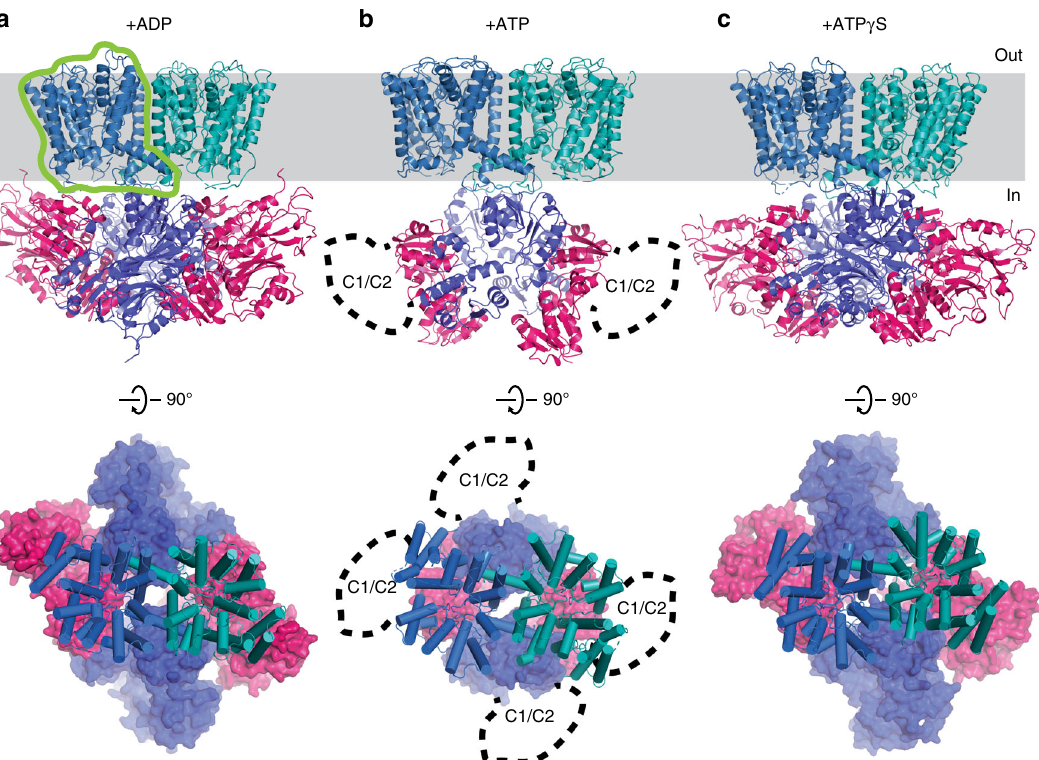
Fig. 1 Structure of TrkHA in the presence of ADP, ATP, or ATP γ S. a – c Structures of the TrkH (blue and teal)-TrkA (dark blue and purple) in the presence of ADP ( a ), ATP ( b ), or ATP γ S ( c ), viewed within the plane of the membrane (top) and from the periplasmic side (bottom). The green outline indicates an individual TrkH